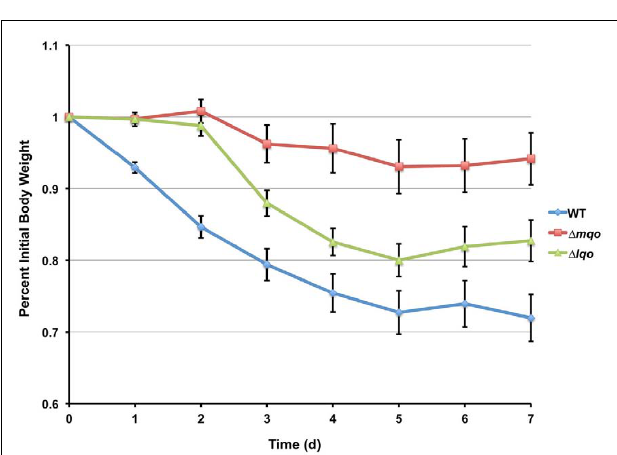
FIGUREA5 | Both Mqo and Lqo are required for full virulence in S. aureus . Eight female C57BL/6 mice (two independent experiments each involving four mice per group) were inoculated i.v. with 5 × 10 6 cfu of S. aureus strain Newman or isogenic mutants.Weight loss was documented and mice losing ≥ 30% of their body weight at the time of inoculation were sacrificed as per approved IACUC protocols.